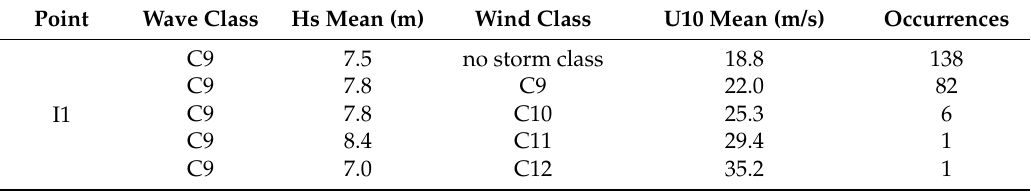
Table 8. Maximum wind and wave conditions according to the Beaufort scale for the North Sea. Point Wave Class